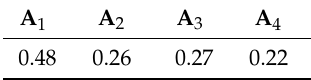
Figure 6. ( a ) < λ c / β > versus θ at various U from 5 to 20 m/s at an interval of 5 m/s, and ϕ is fixed at 40° ; and ( b ) < λ c / β > versus ϕ at various U from 5 to 20 m/s at an interval of 5 m/s, and θ is fixed at 30°. Table 1. Coefficients in Equation (6), which are determined from the collocated data in our study.